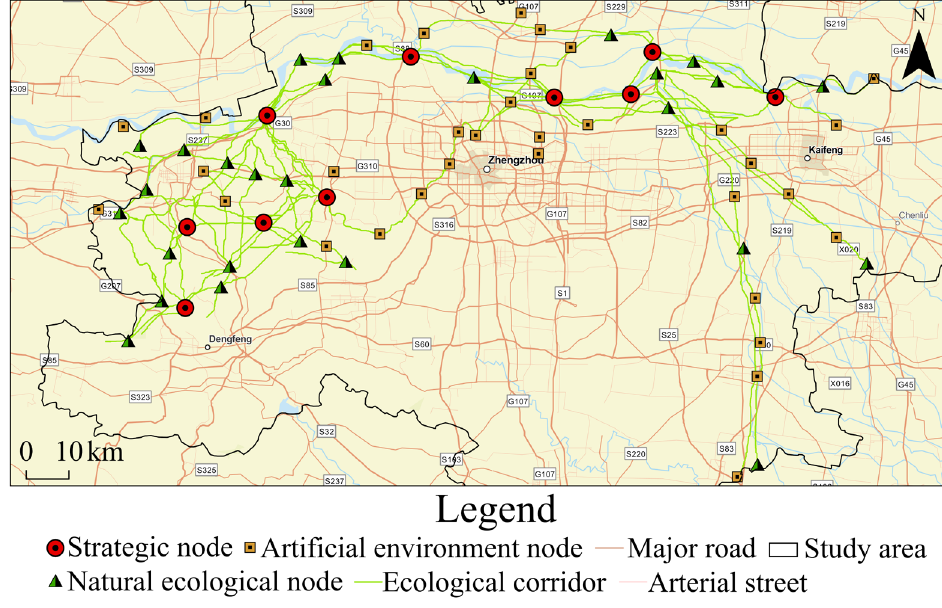
Figure 8. Determination of ecological nodes.